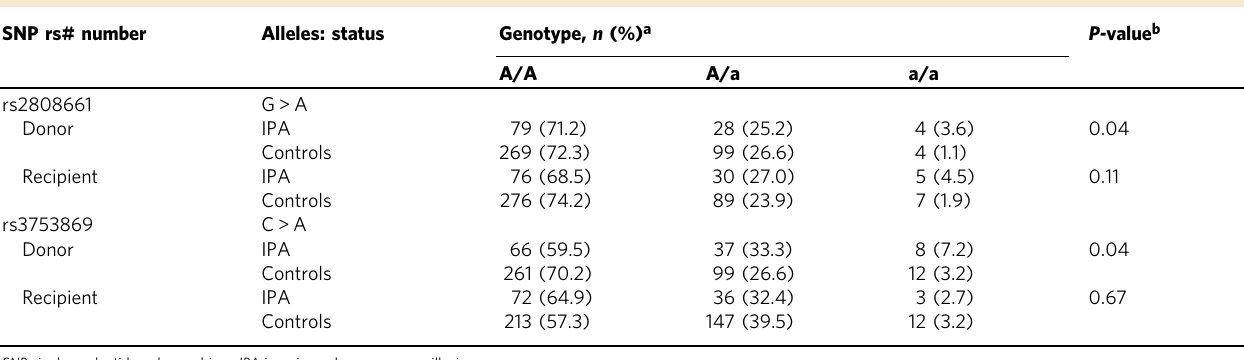
Table 1 Genotype distribution of APCS genotypes among cases of IPA and